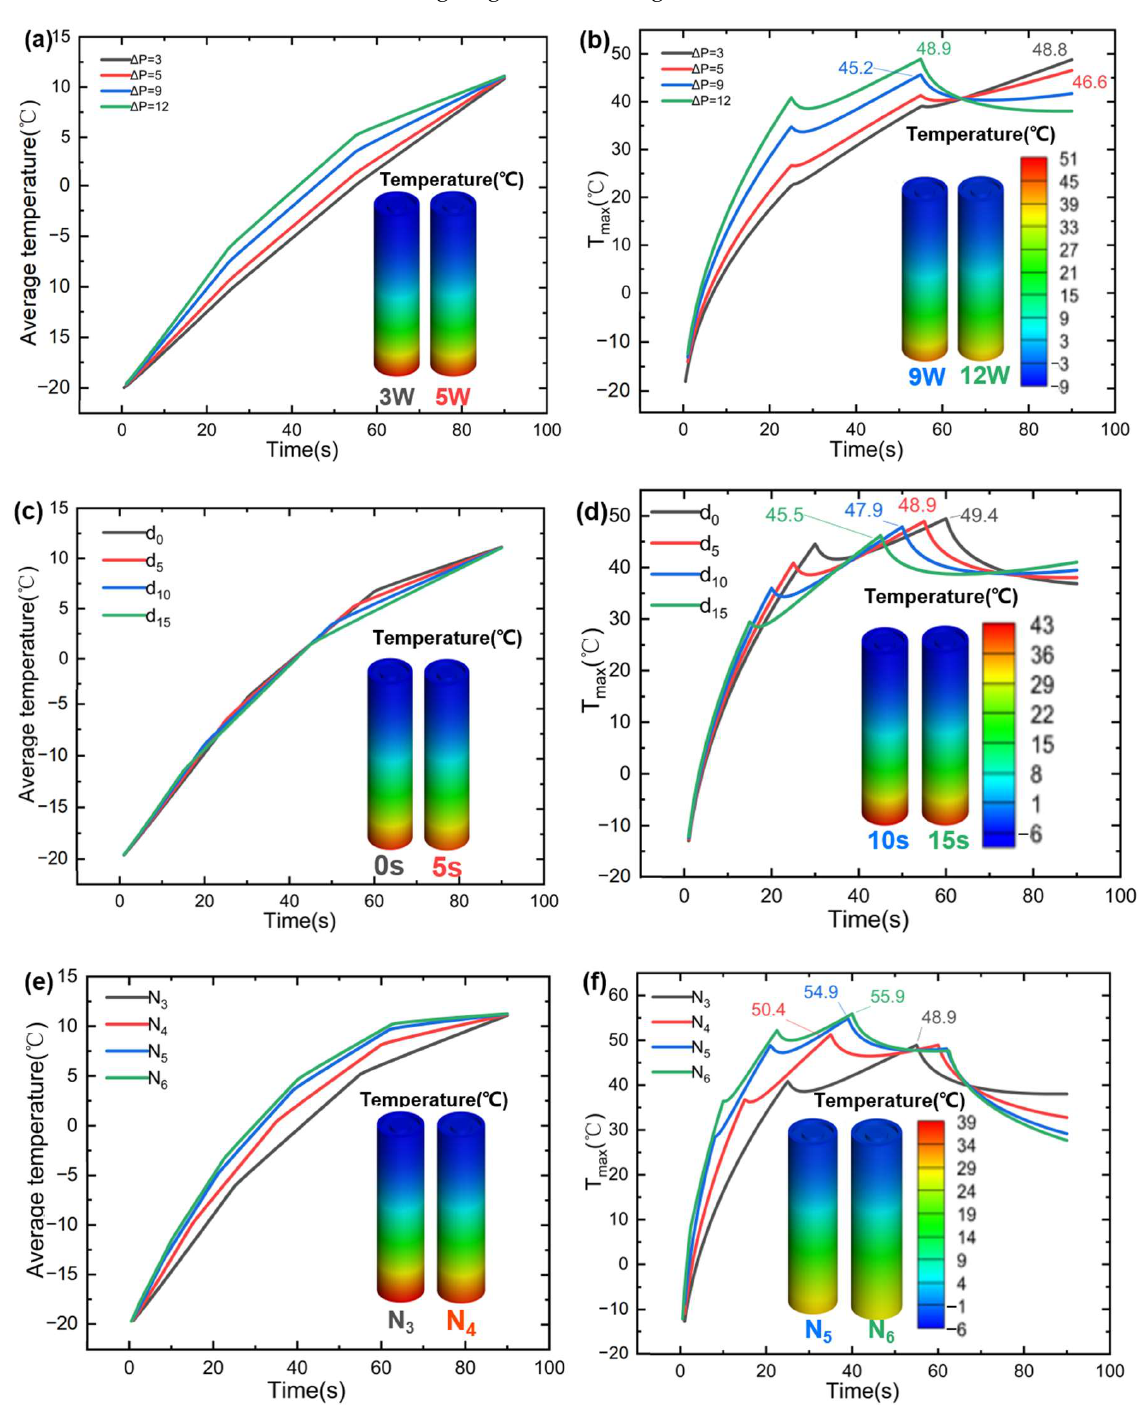
Figure 16. Temperature evolution and surface distribution of the cell. ( a , b ) Power step gradients ∆ P; ( c , d ) Heating time gradients for each stage d; ( e , f ) Number of heating stages N.